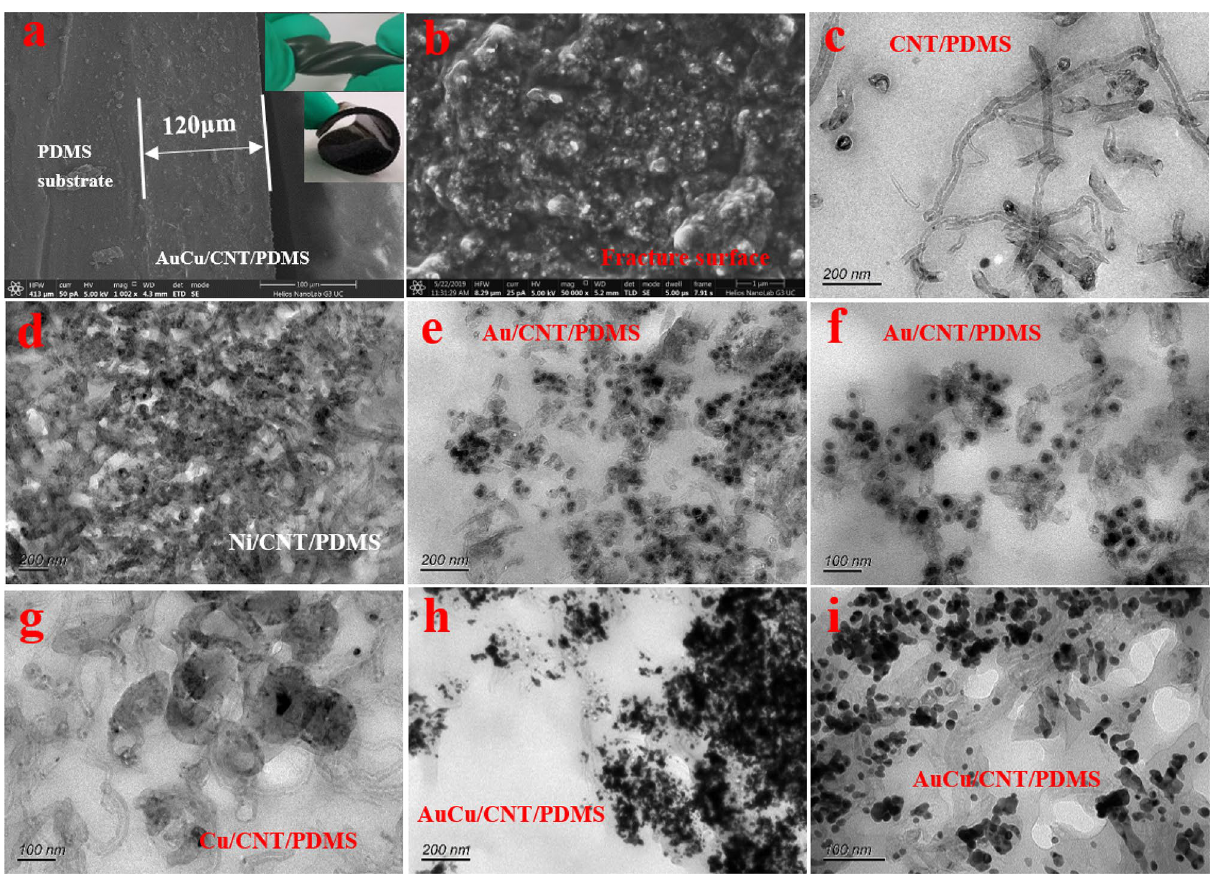
Figure 4. SEM morphology of ( a ) Cross section and ( b ) Fracture surface of AuCu/CNT/PDMS films. TEM morphology of ( c ) CNT/PDMS samples, ( d ) Ni/CNT/PDMS samples, ( e , f ) Au/CNT/PDMS samples, ( g ) Cu/ CNT/PDMS samples, ( h , i ) AuCu/CNT/PDMS